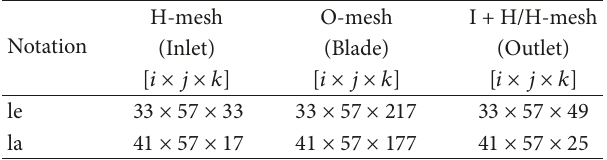
Table 3: The mesh distributions of the turbine